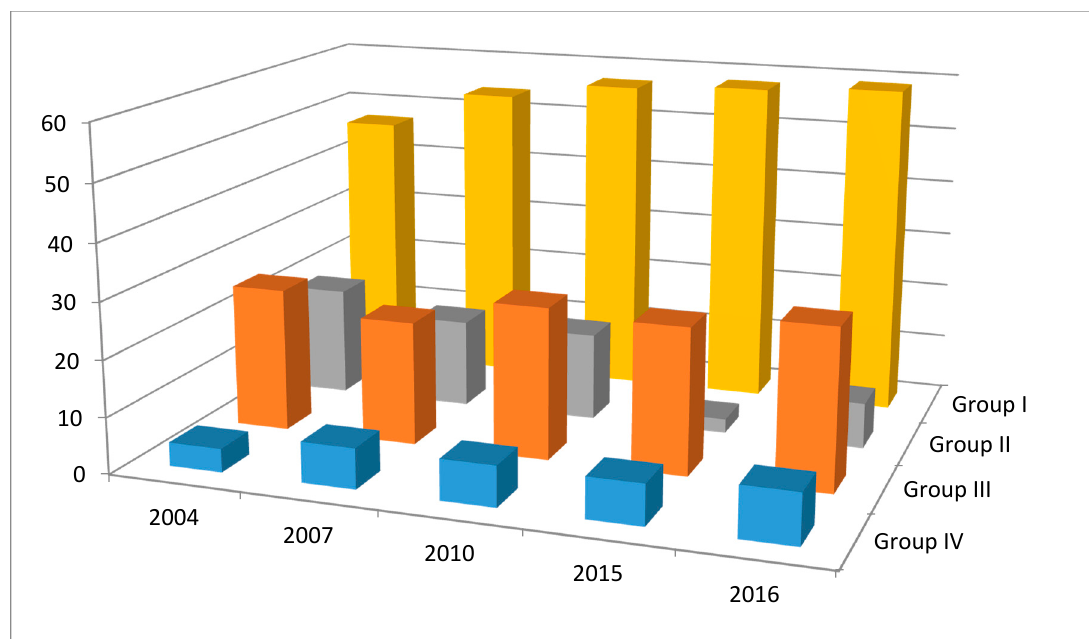
Figure 2. Comparison of trends in percent of Baby-Friendly hospitals designated from the period 2004 to 2016 in the four groups of the 22 countries of the Eastern Mediterranean region of the World Health Organization. Country Groups include 8 countries in advanced nutrition transition stage (group I), 5 countries in early nutrition transition stage (group II), 4 countries with significant undernutrition (group III), and 5 countries in complex emergency (group IV).